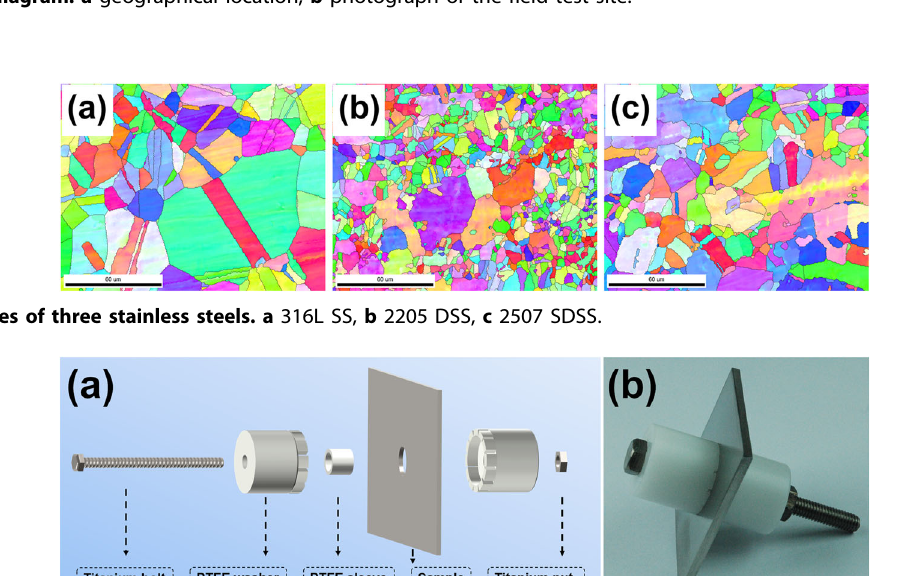
Fig. 13 Field test diagram. a geographical location, b photograph of the fi eld test site.